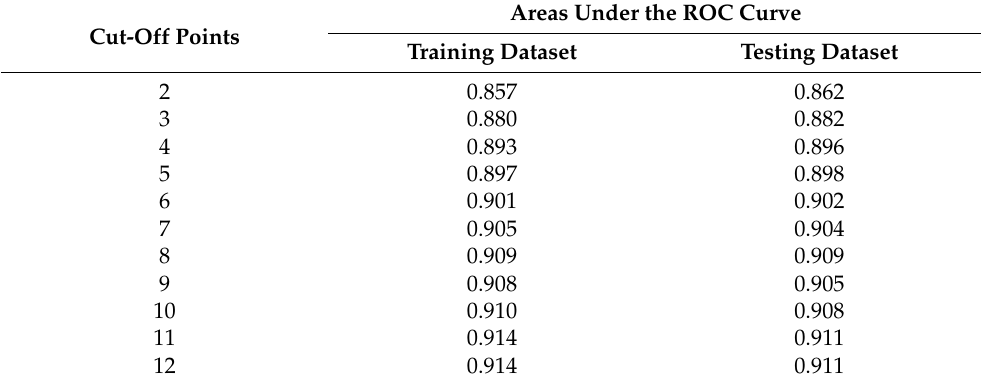
Table 1. Ability of the model to predict alcohol consumption * above a given level ( ≥ 2, 3, 4, . . . , 12 drinks) during the last drinking occasion. Areas Under the ROC Curve Cut-Off Points Training Dataset Testing Dataset